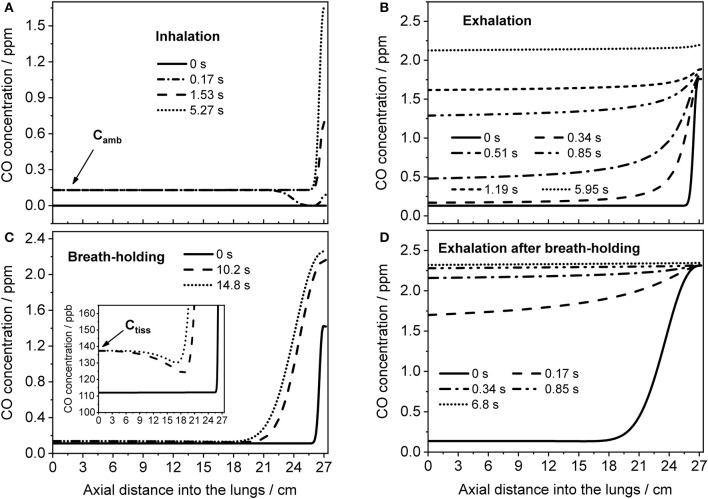
Axial distributions of CO along the respiratory tract for several instances during inhalation (A) and subsequent exhalation (B) at 121 ml/s (parameters from Figure 4B), and during a 20-s BH maneuver (C) followed by exhalation (D) at 151 ml/s (parameters from Figure 4D). Inhaled CO and airway tissue concentrations are indicated in (A,C), respectively.